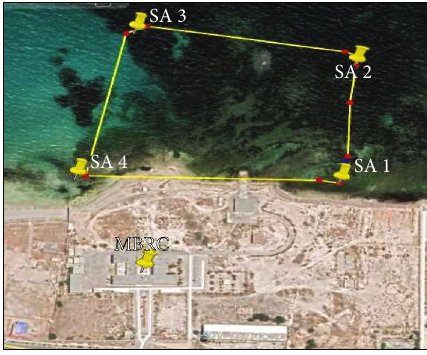
Figure 1: Algae collection site locations. (MBRS: Marine Biology Research